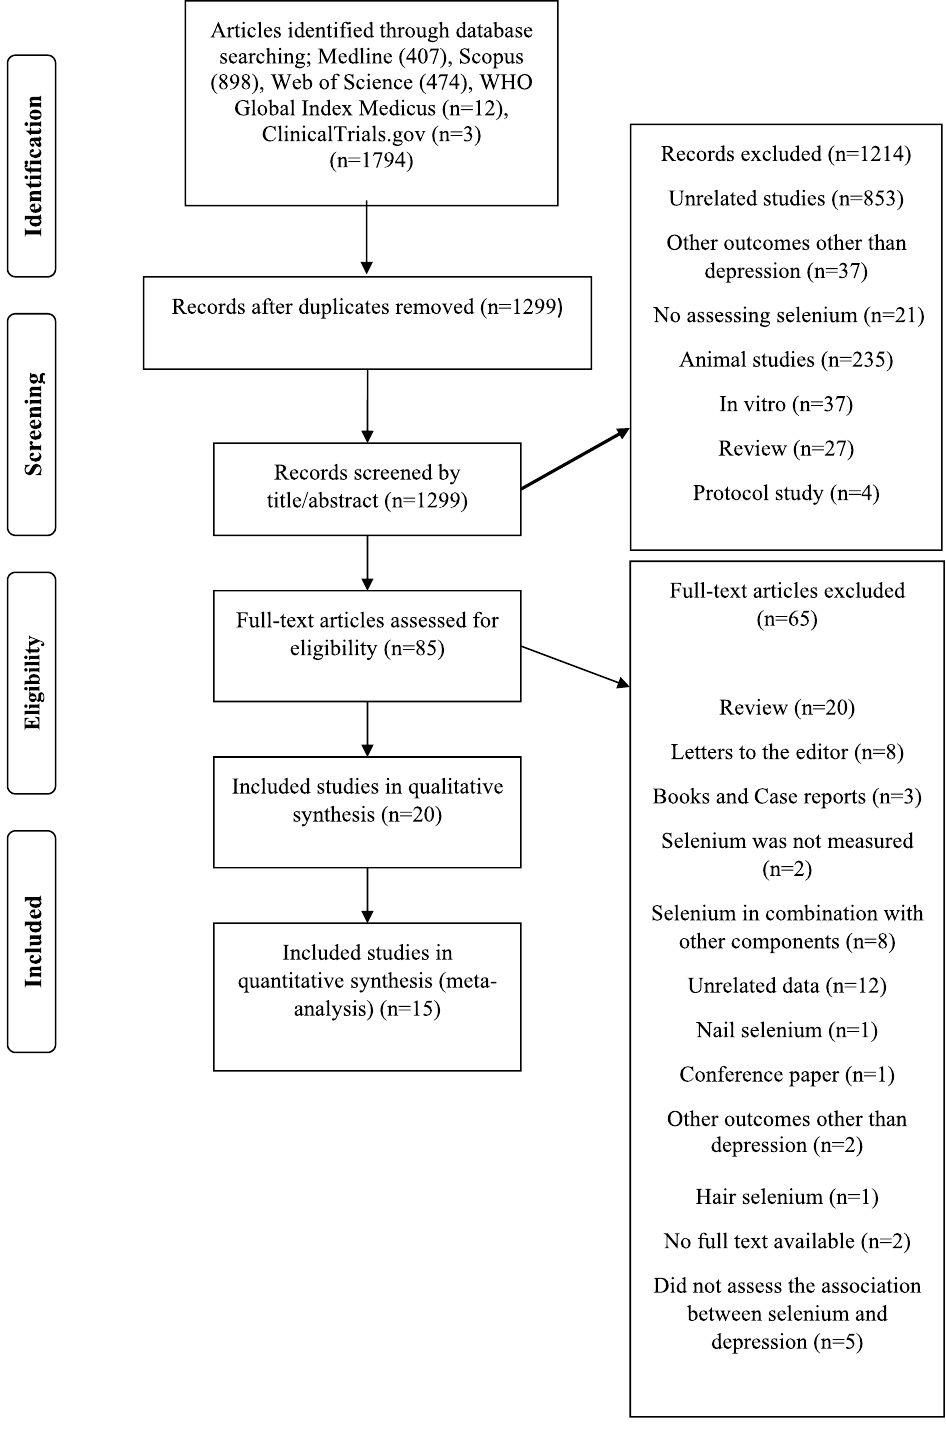
Figure 1. Flow diagram of the study selection